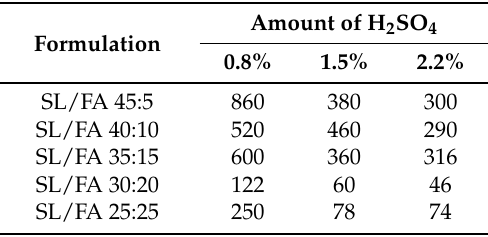
Table 2. Gel-time in seconds of SL/FA formulations hardened with different amount of catalyst at 100 °C. Formulation